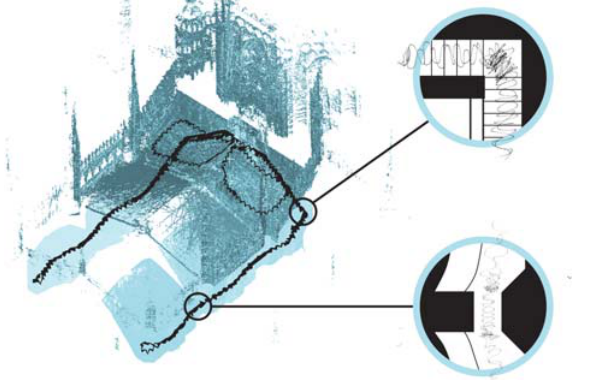
Figure 5. Orthogonal view of the ZEB1 point cloud showing the